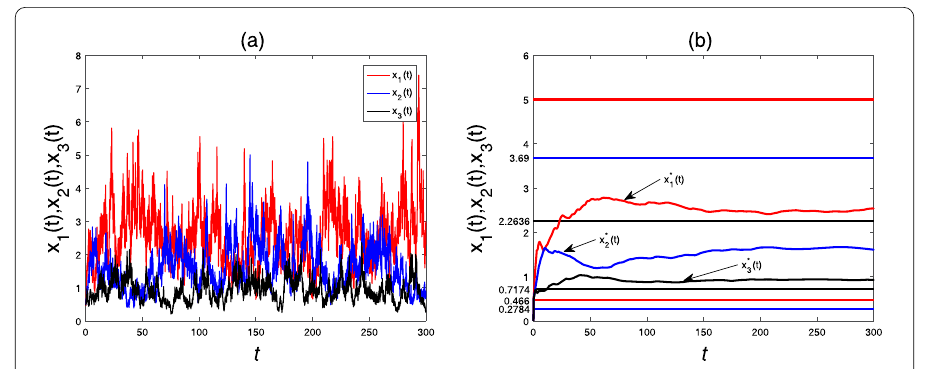
Figure 7 Persistence in the mean of system (2). (a) Time sequence diagram and (b) the phase portrait of system (2).( x